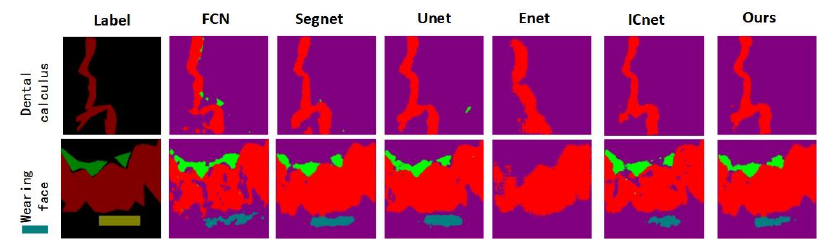
Figure 13. Visual comparison of segmentation results of dental calculus and worn surface.